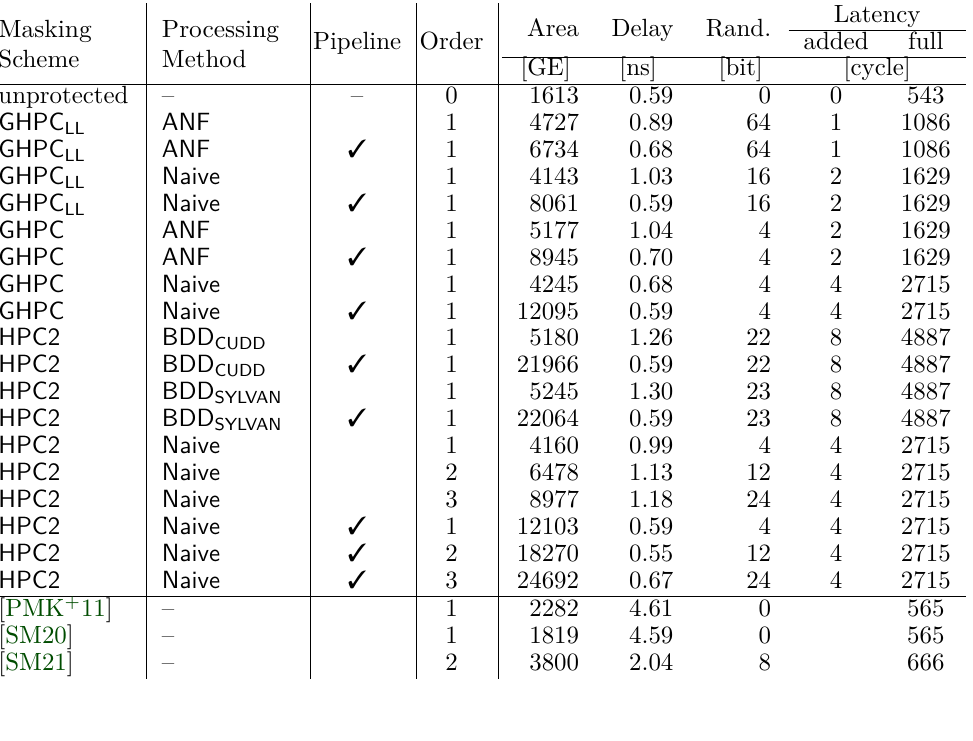
Table 12: Synthesis results, PRESENT nibble-serial encryption function.